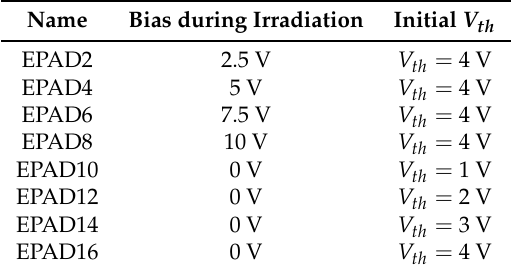
Table 1. EPADs with static bias during irradiation.